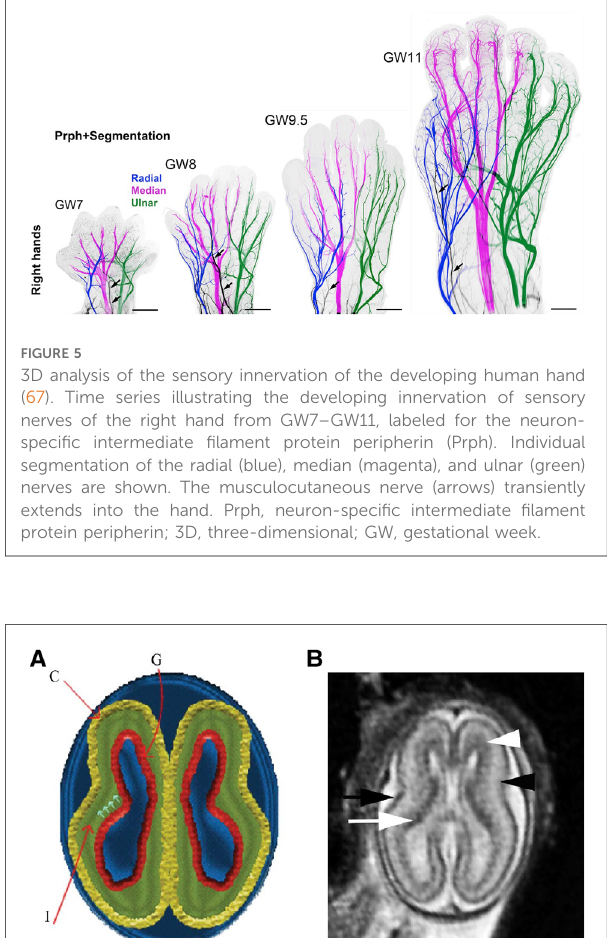
7 different fetal facial expressions in response to anesthetic puncture of the fetal thigh during intrauterine surgery. Blinded